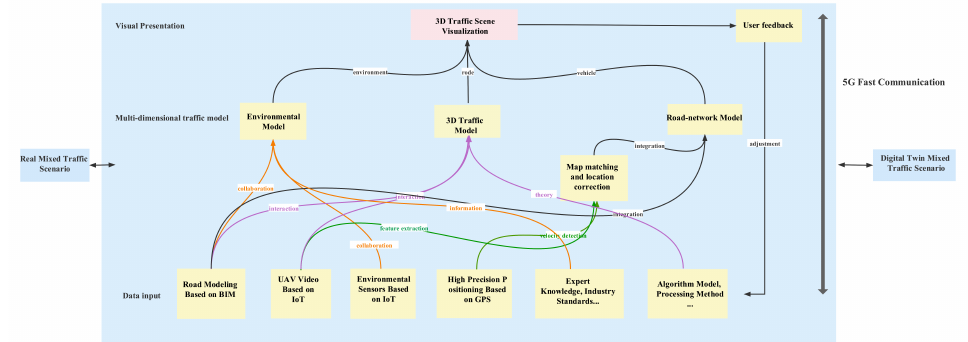
Figure 3. Data interaction between multiple physical entities. Building information data, UAV video data and environmental sensor data belong to physical entity data. Expert knowledge, professional standards, etc. belong to knowledge data. Algorithm models, processing methods and so on belong to services data. Emulator data belongs to virtual entity data. Then the four kinds of data are preprocessed and integrated to acquire the fusion-derived data. User feedback is used as the basis for data structure adjustment. Efficient data transmission using 5G wireless